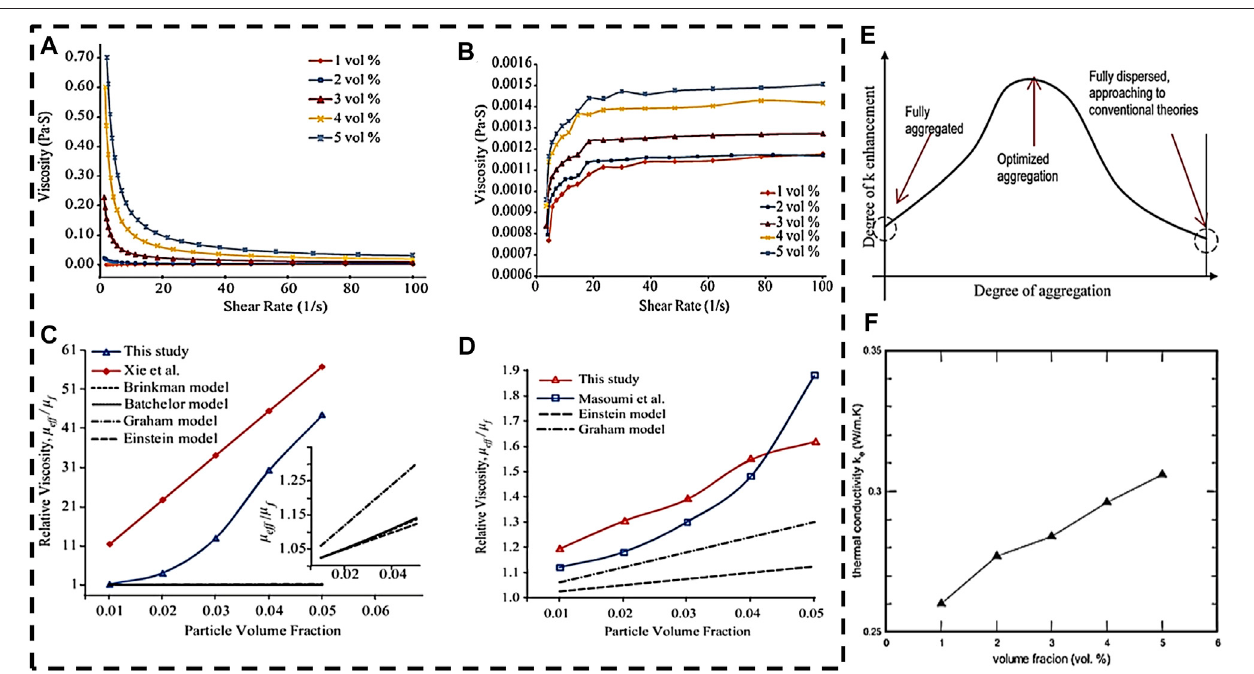
FIGURE3| Physicalpropertiesofnano fl uids. (A – D) effectofthestabilityontheviscosity ofAl2O3nano fl uidsatdifferentconcentrations, (A) viscosityasfunctionof the shear rate 2 weeks after preparation, (B) viscosity as a function of the shear stress after re-sonication, (C) relative viscosity 2 weeks after preparation, (D) relative viscosity after re-sonication. (E) Effect of aggregation on the thermal conductivity enhancement of nano fl uids. (F) The thermal conductivity of CuO nano fl uids as a function of volume fraction. Reproduced with permission (Mukherjee et al., 2018; Liu et al., 2006). Copyright 2018 and 2006, Wiley Online Library.